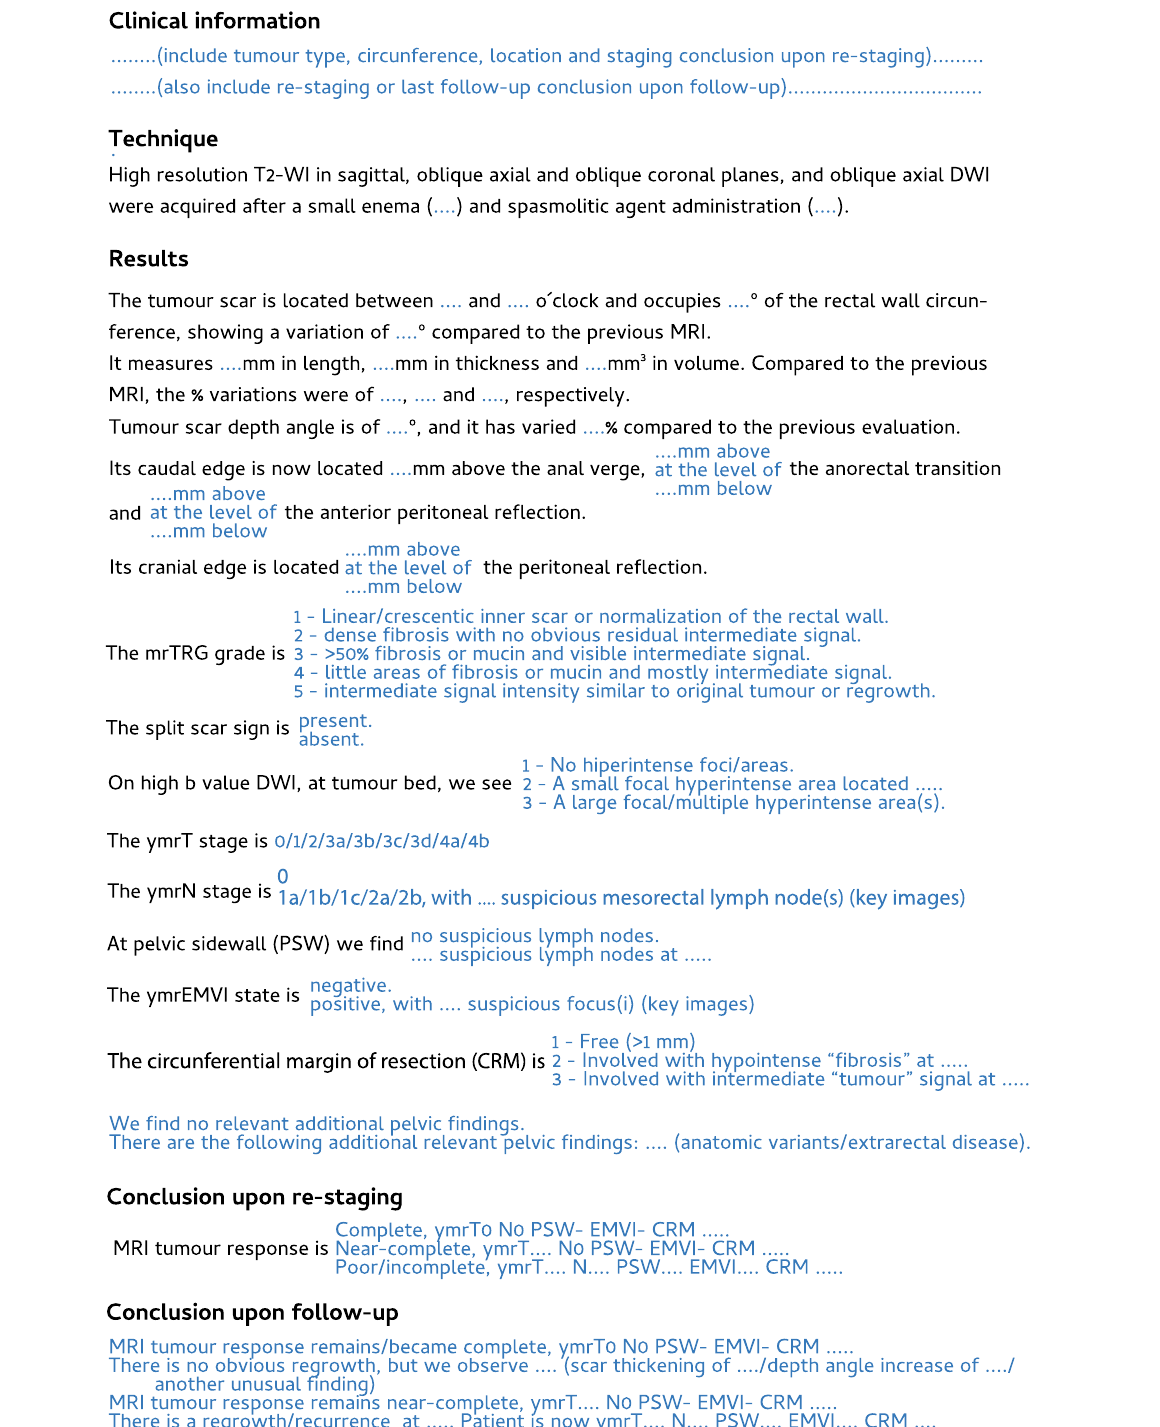
Fig. 11 Re-staging and follow-up report template. Our proposed standardised report template is depicted. In blue, a single option should be